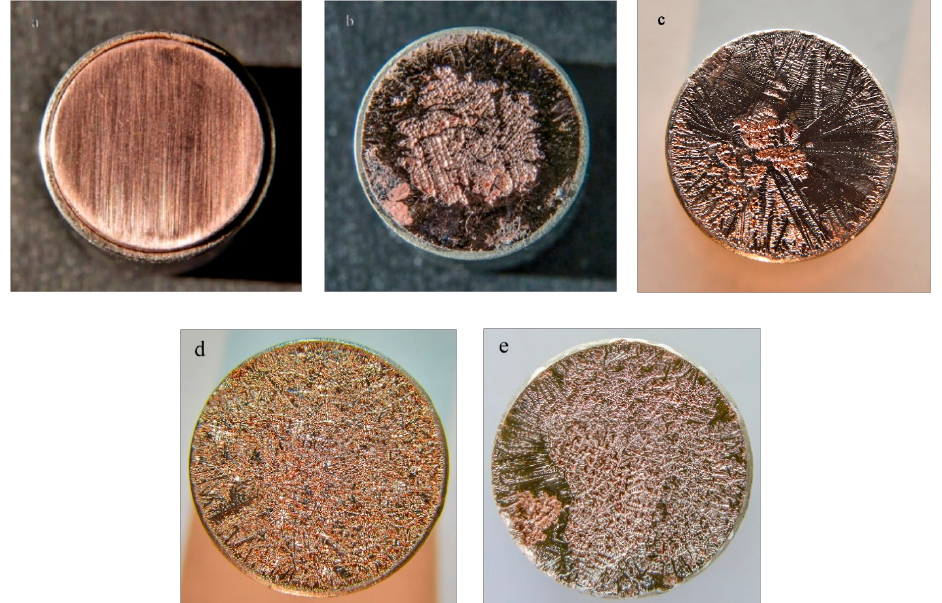
Figure 4. Photographs of the surface of solid copper samples ( a ) before the experiments and ( b – e ) after the experiments: ( b , c )— p = 10 kPa, ( d , e )— p = 30 kPa, ( b , d )—the probe laser was on, ( c , e )—the probe laser was off during the experiment.